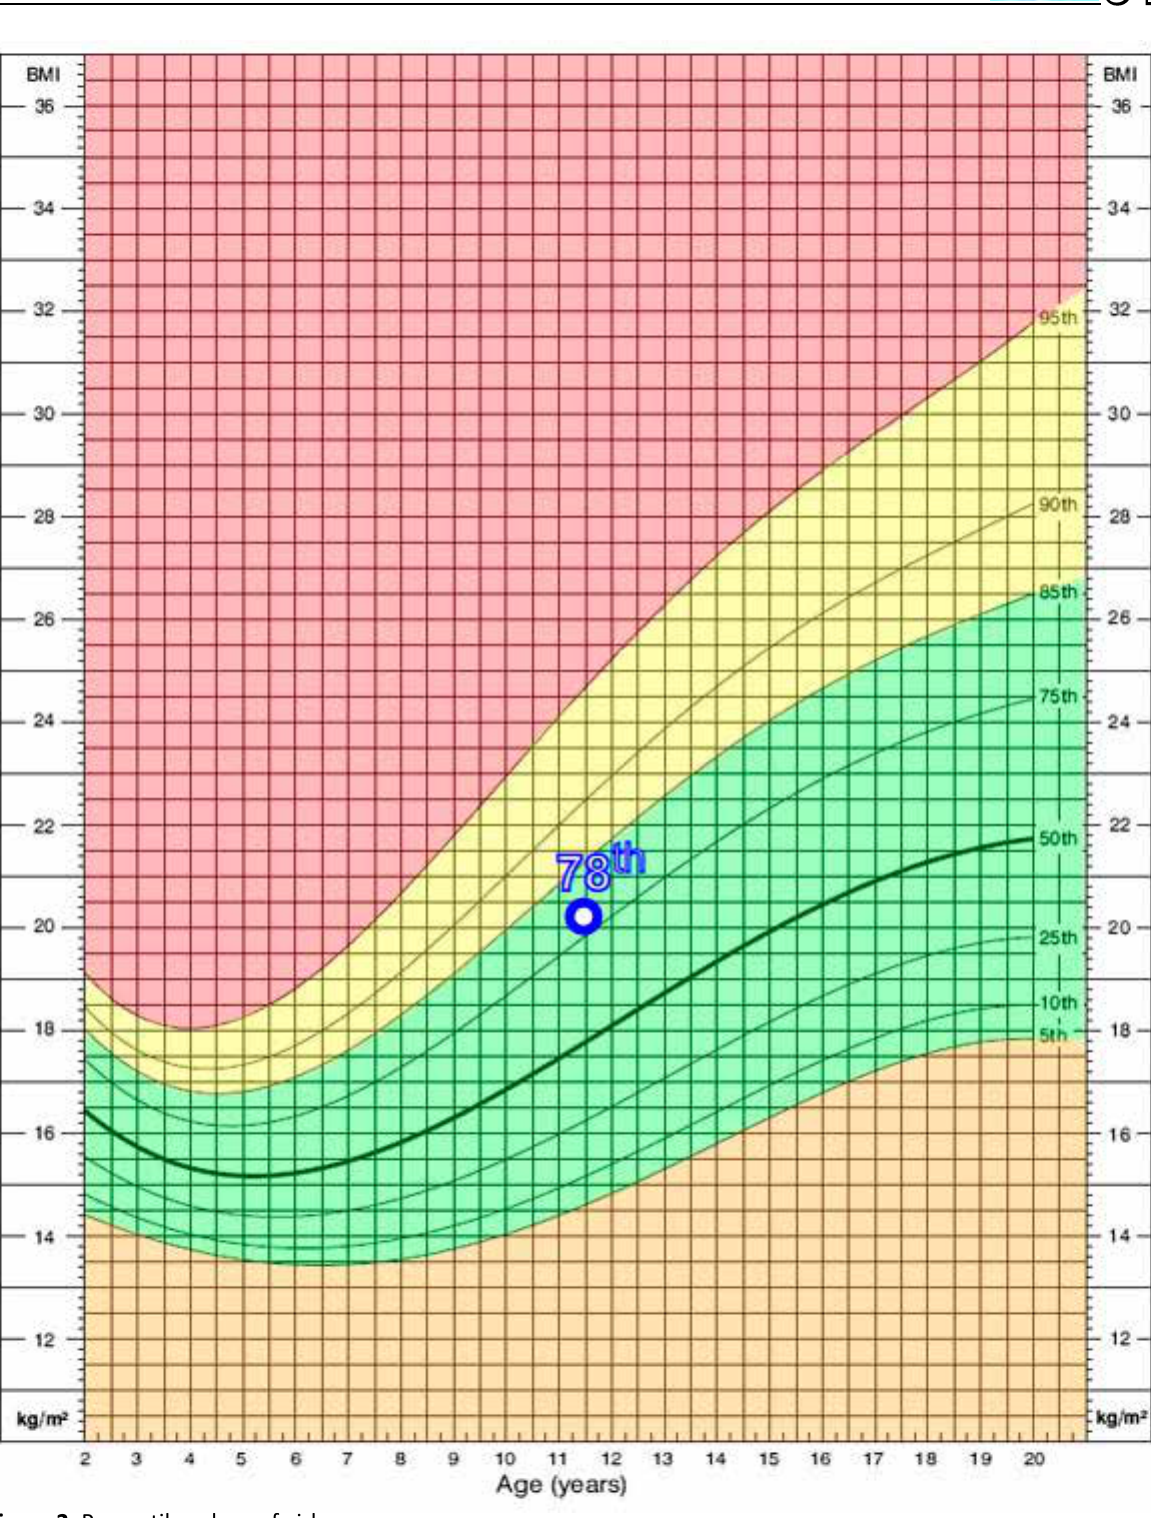
Figure 2. Percentile values of